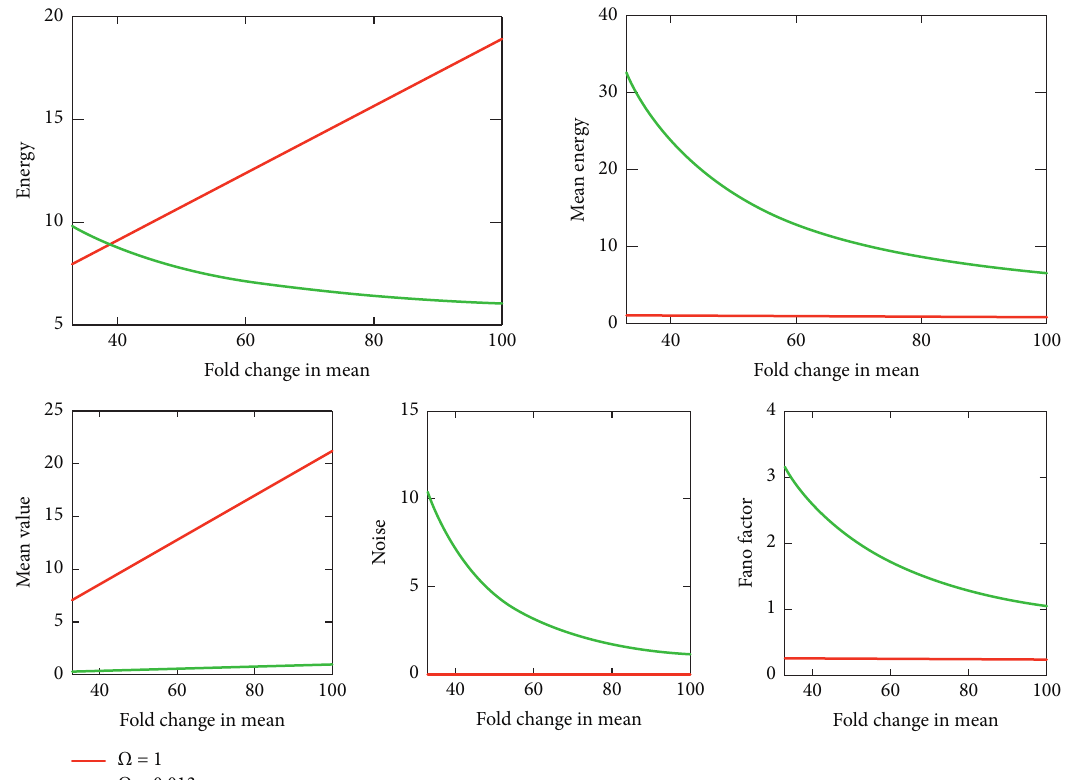
Figure 6: Free energy consumption of dual repression and its effect on gene expression (mean, noise, and Fano factor); parameter values are set as k on R � 0 . 27 ,k off R � 0 . 23, and μ � 33.